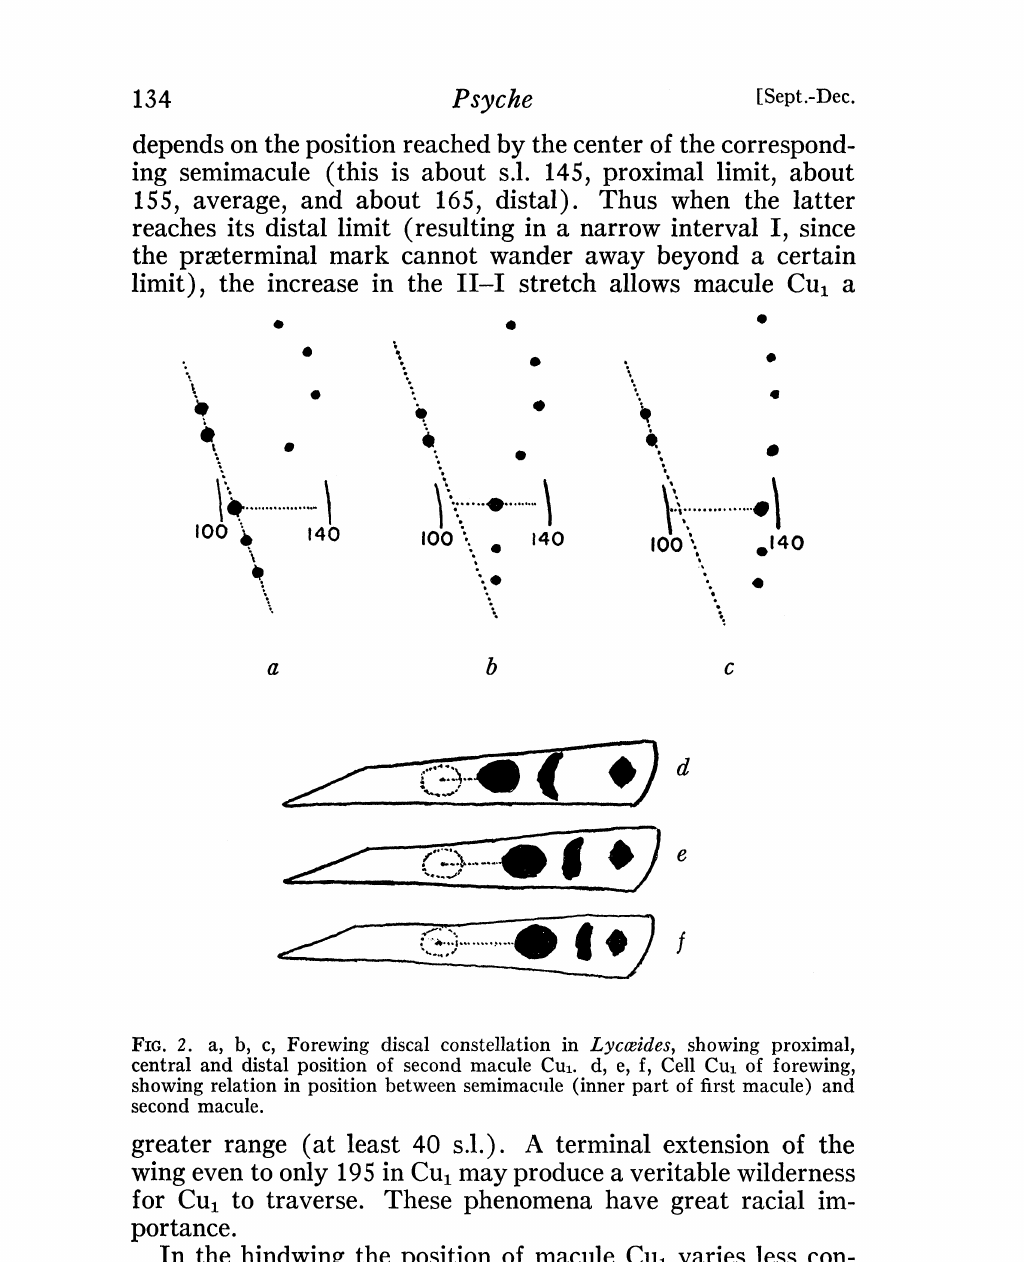
FI. 2. a, b, c, Forewing discal conste]|ation in Lycceides, showing proximal, central and distal position of second macule Cul. d, e, f, Cell Cul of forewing, showing relation in position between semimacule (inner part of first macule) and second